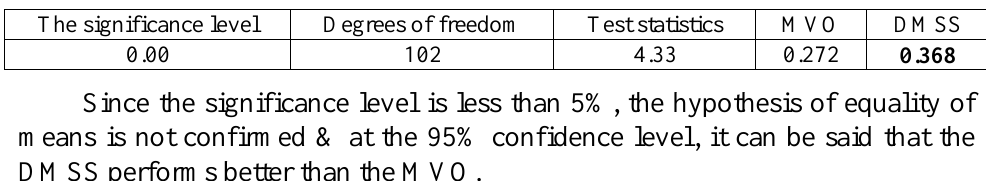
Table 7. Student's t-test results (research